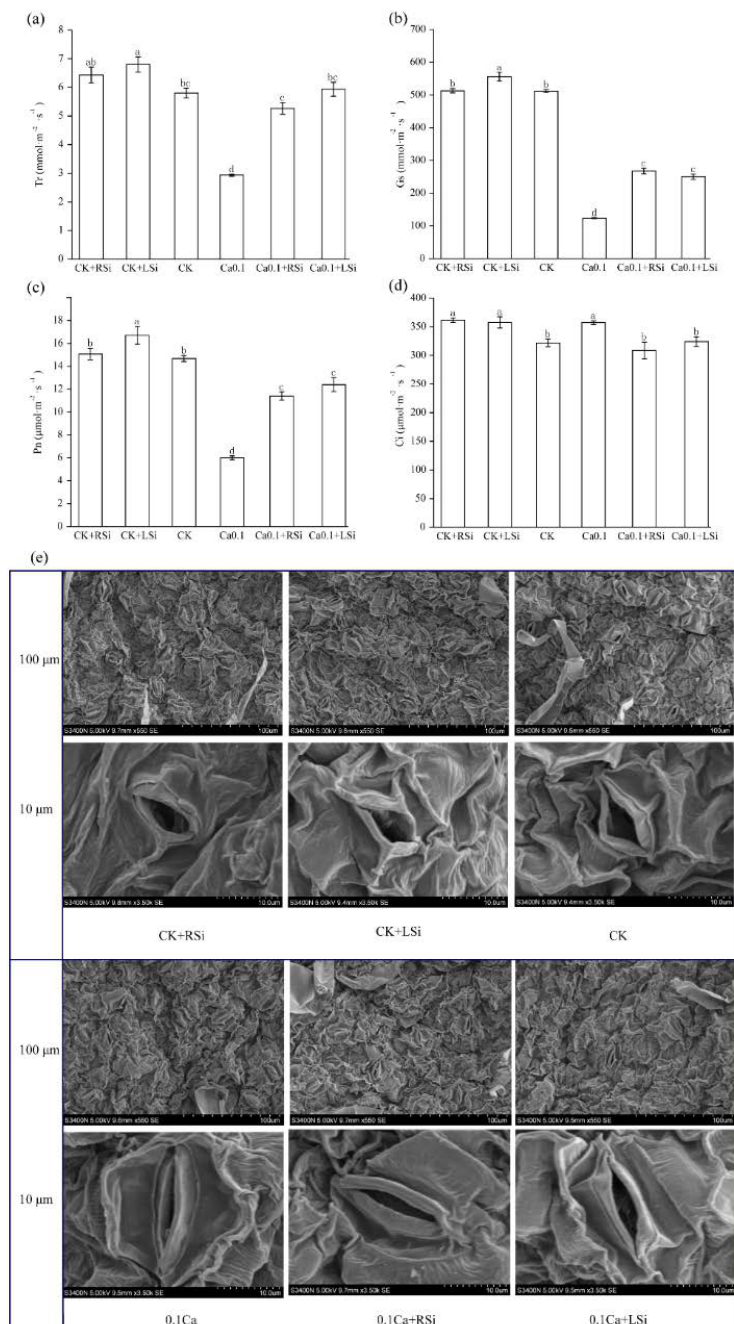
Figure 4. Effect of exogenous Si on stomatal morphology and photosynthetic characteristics of tomato leaves under low − calcium stress. ( a ) Transpiration rate; ( b ) stomatal conductance; ( c ) net photosynthetic rate; ( d ) intercellular carbon dioxide, ( e ) scanning electron microscope imaging of tomato leaf stomata. The means of three replicates ± standard error is shown. The data were subjected to an ANOVA test to determine the LSD, and bars superscribed by different letters are significantly different at p < 0.05. Standard errors are indicated by bars. CK + RSi: 4 mM Ca in Hoagland nutrient solution + root application of 1 mM Si; CK + LSi: 4 mM Ca in Hoagland nutrient solution + foliar application of 1 mM Si; CK: 4 mM Ca in Hoagland nutrient solution; 0.1Ca: 0.1 mM Ca in Hoagland nutrient solution; 0.1Ca + RSi: 0.1 mM Ca in Hoagland nutrient solution + root application of 1 mM Si; 0.1Ca + LSi: 0.1 mM Ca in Hoagland nutrient solution + foliar application of 1 mM Si.